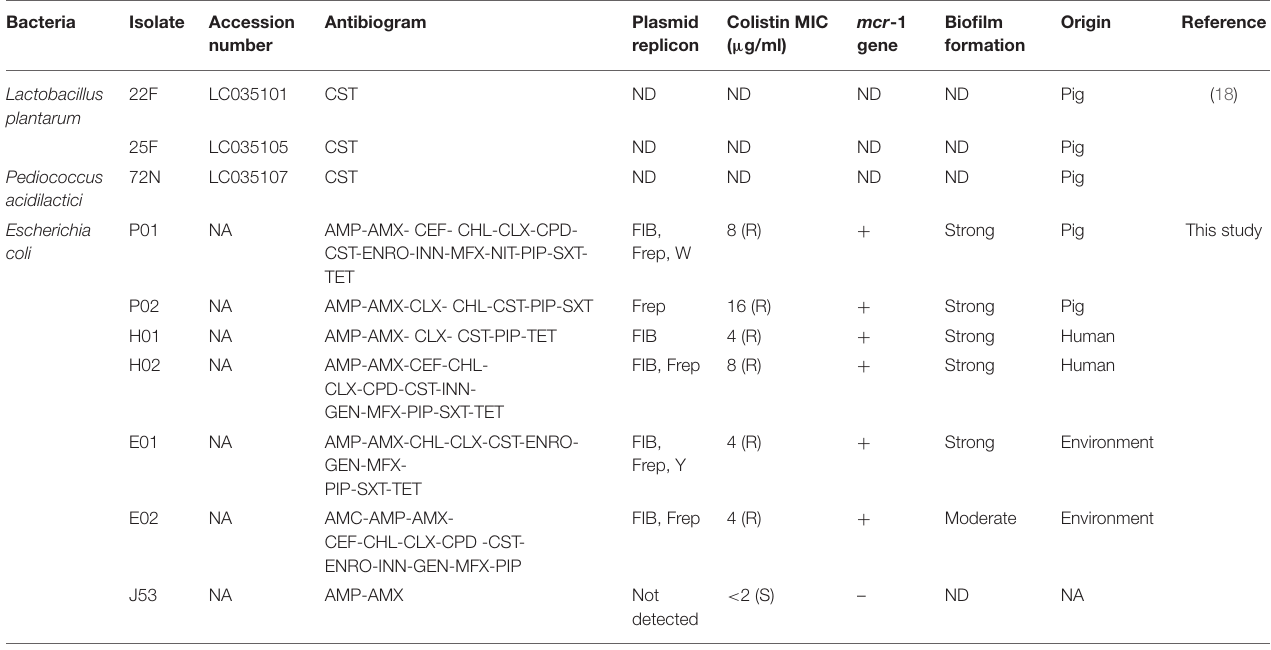
TABLE 1 | Profiles of lactic acid bacteria and Escherichia coli strains used in this study. Bacteria Isolate Accession